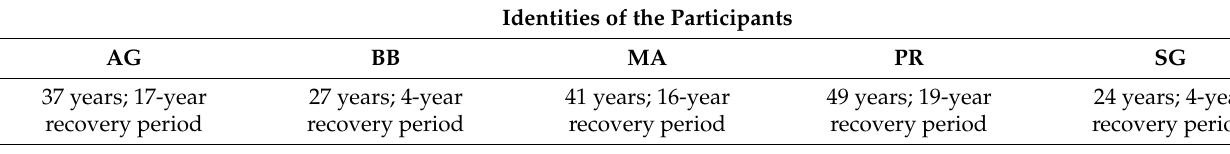
Table 4. ACEs and other life crises before drug